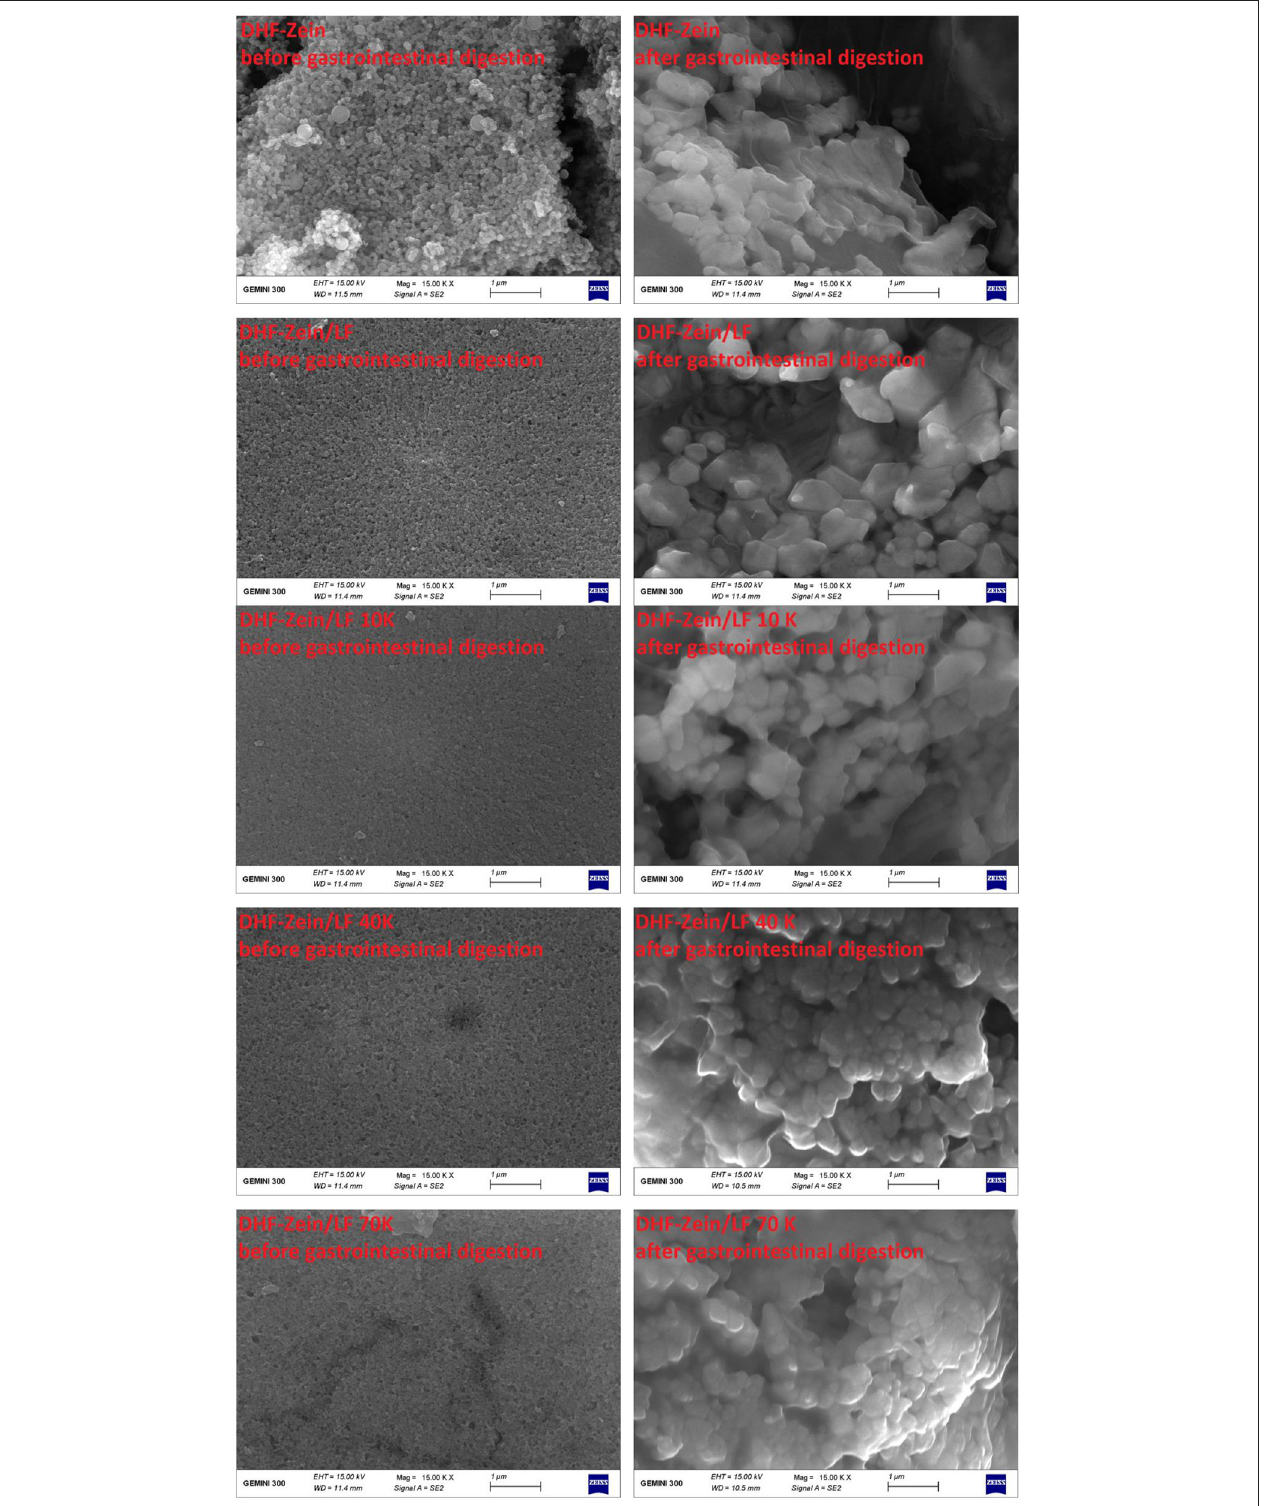
FIGURE 11 | Influence of in vitro digestion on the FE-SEM images of DHF-zein, DHF-zein/LF, DHF-zein/LF 10K, DHF-zein/LF 40K, and DHF-zein/LF 70K. Pictures were taken at × 15,000 magnifications.